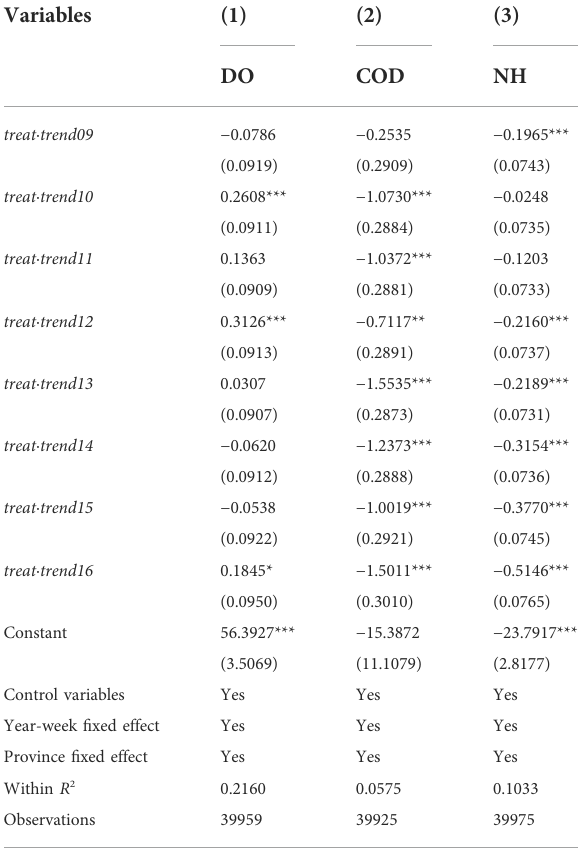
TABLE 3 Dynamic trend test